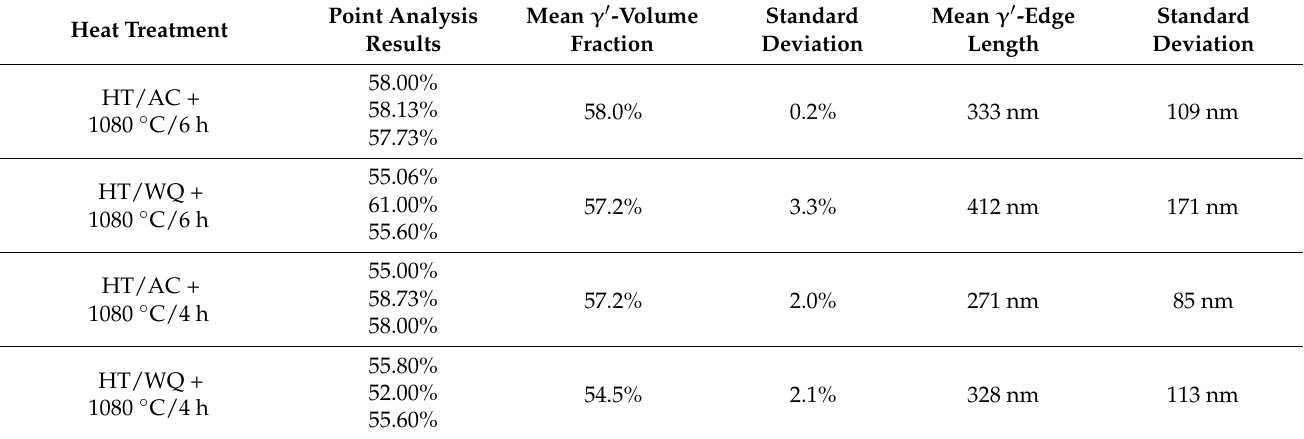
Table 4. γ (cid:48) -edge length and γ (cid:48) -volume fraction of the AC and WQ samples with additional heat treatment at 1080 ◦